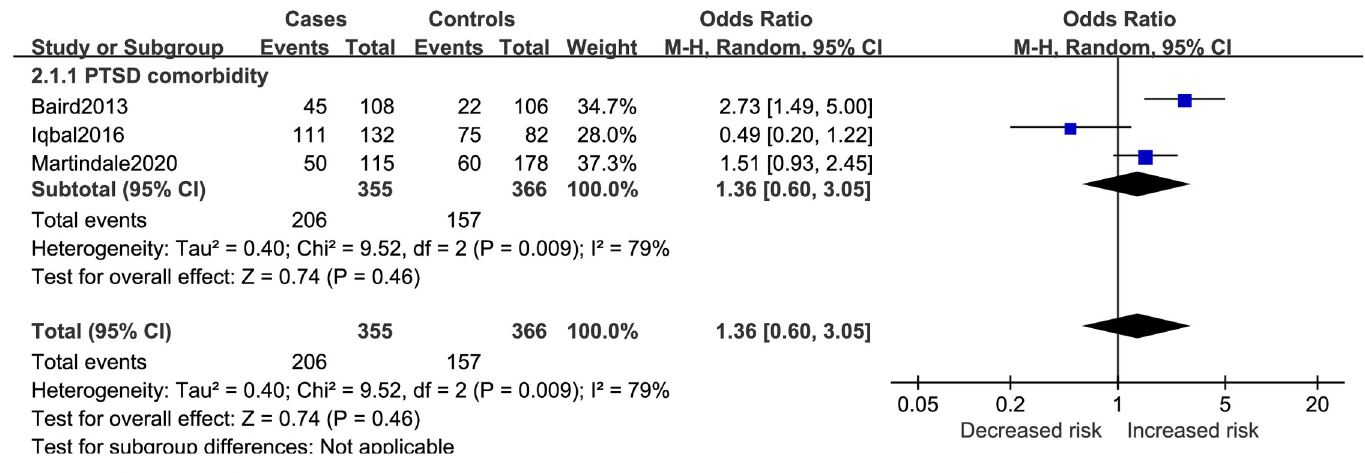
Fig 4. Comorbidity factor for SDB in